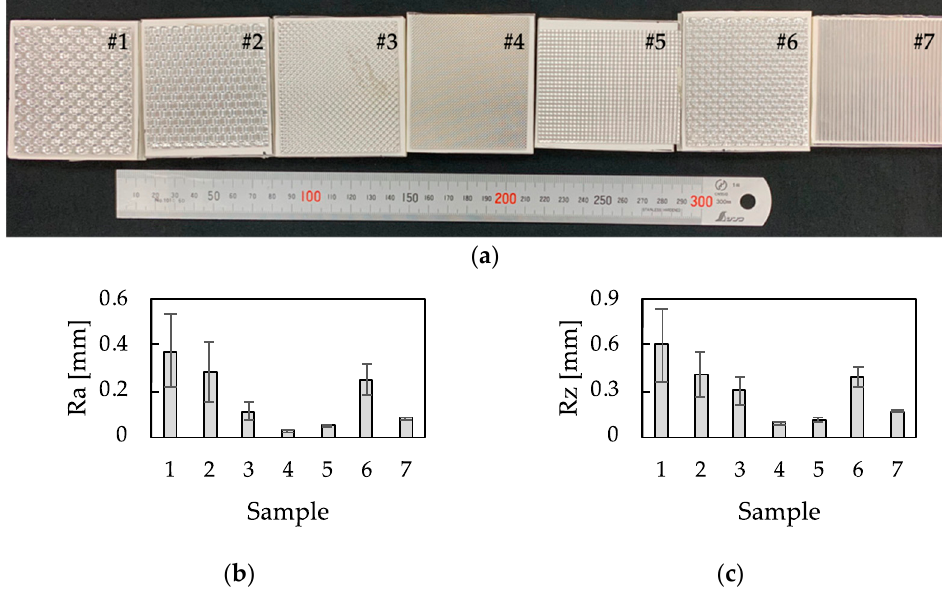
Figure 2. Information about seven aluminum samples. All samples are embossed. ( a ) Images of aluminum test samples. The sample number is given above each sample. ( b ) The arithmetic mean roughness (Ra), ( c ) the maximum height (Rz) ( n = 10, mean ± SD